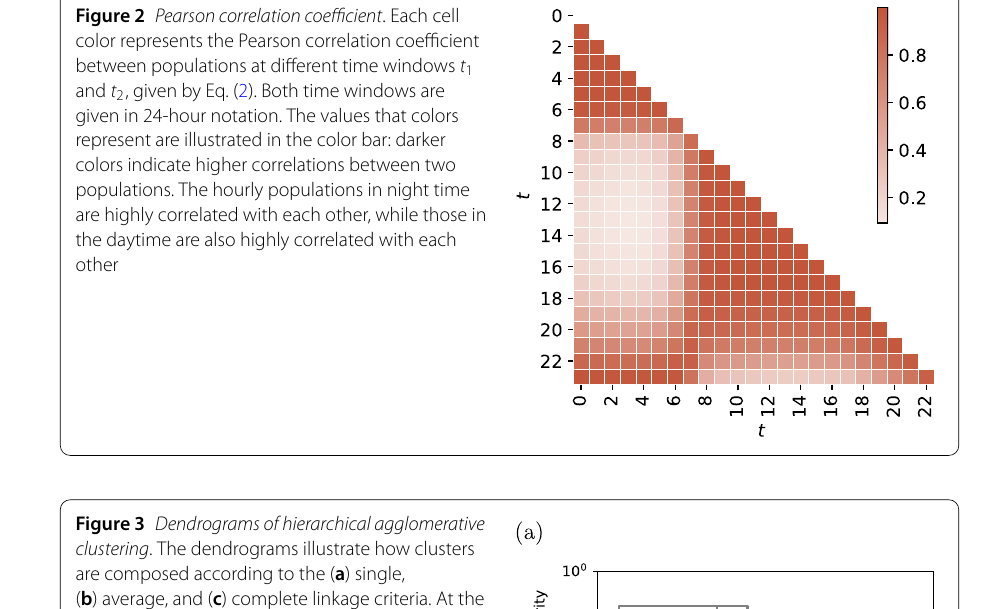
Figure 3 Dendrogramsofhierarchicalagglomerative clustering . The dendrograms illustrate how clusters are composed according to the ( a ) single, ( b ) average, and ( c ) complete linkage criteria. At the start of the dendrogram, each time window is labelled with t (= 0,1, ... ,23 in 24-hour notation). From bottom to top, time windows with high correlations are preferentially merged, as depicted by the inverted U-shaped link with the height representing the dissimilarity under each criterion with Eq. (1). Following the dendrograms, one can find the clusters commonly observed in all three criteria. Those with the least dissimilarity are the time windows from t = 0 to 5 (blue links) and from t = 9 to 17 (red links). At this level of dissimilarity in the complete criterion, a cluster including t = 19 and 20 (green links) is additionally